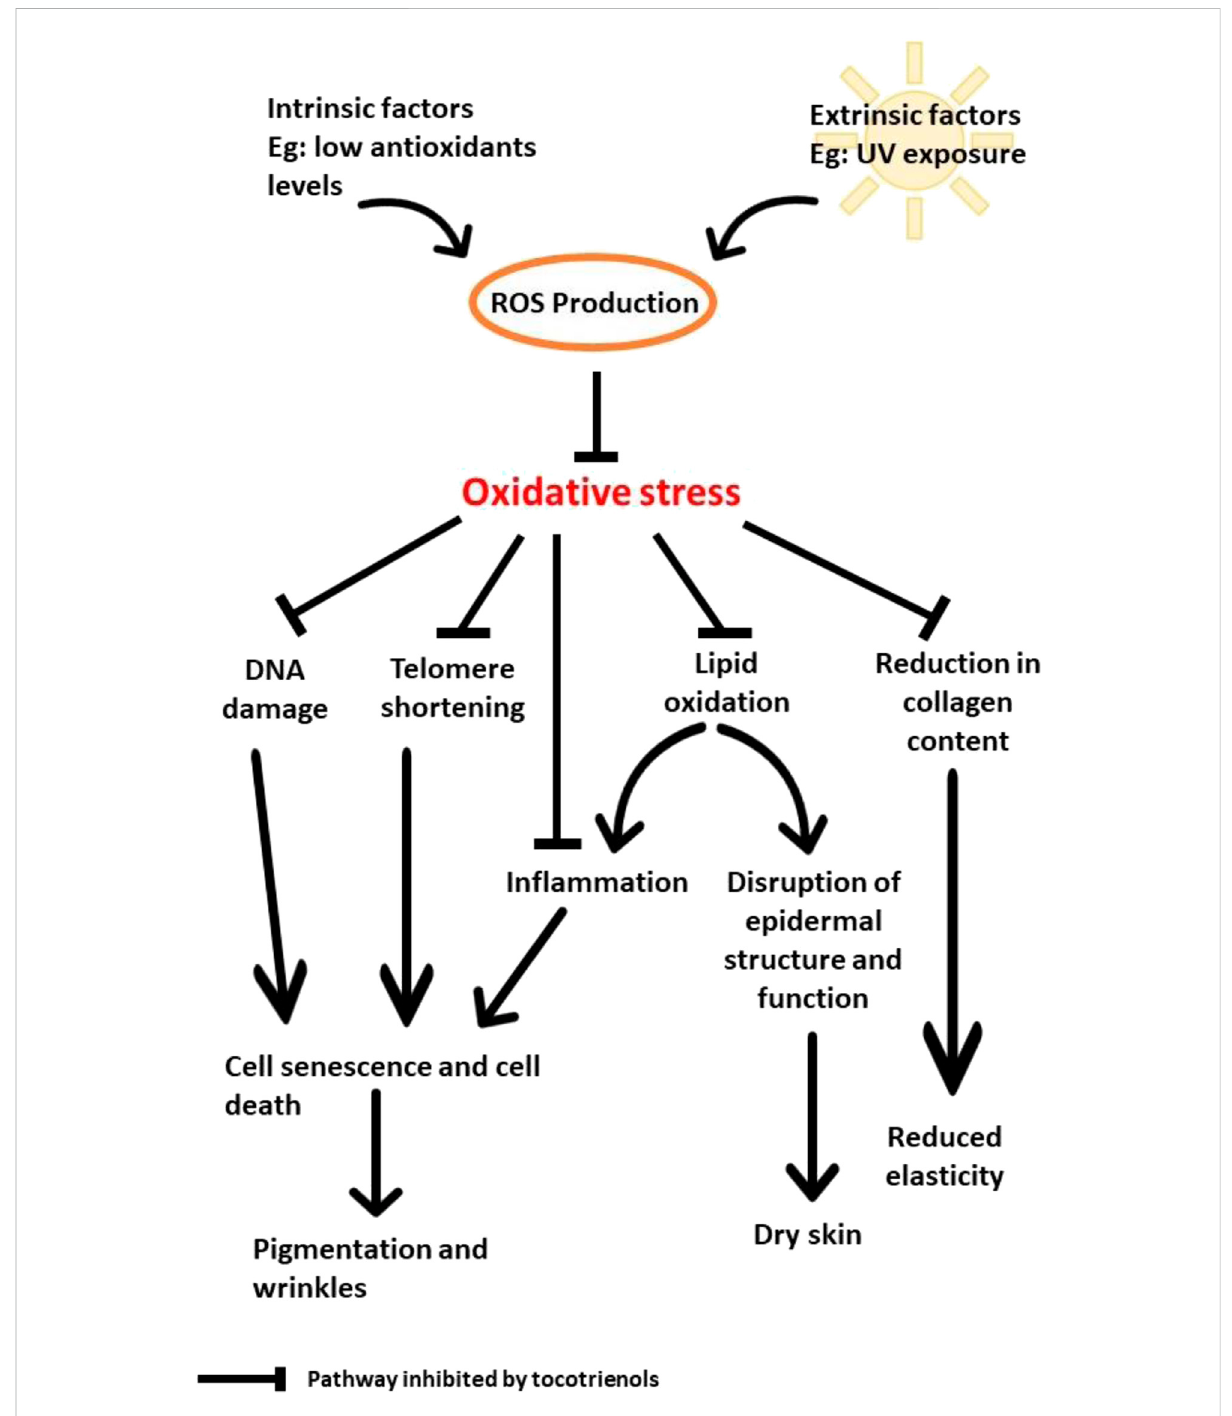
FIGURE 2 The skin aging pathways inhibited by